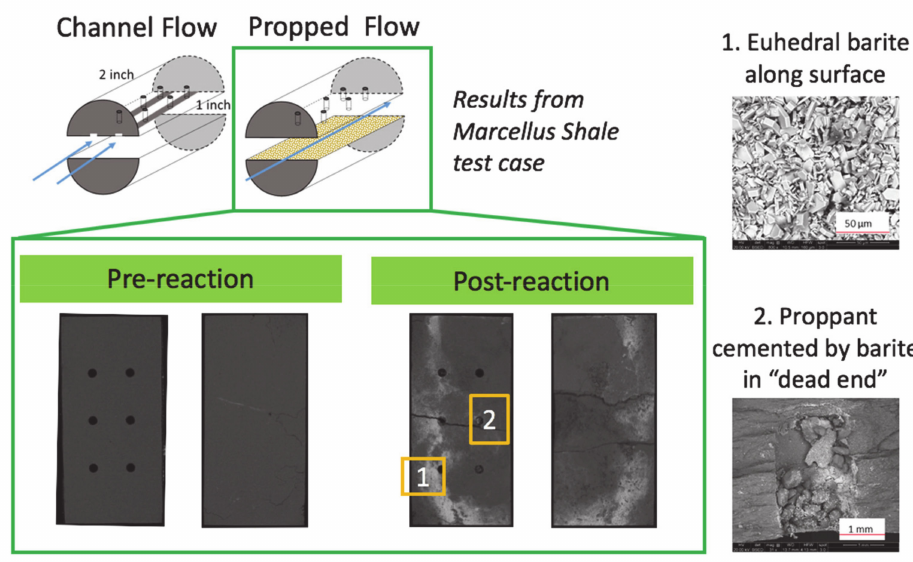
Figure 16. Example with Marcellus Shale of the experimental design for simulating flow through fractured shale [44]. Similar controlled geometry studies are being examined with HFTS Wolfcamp samples as part of this multi-laboratory